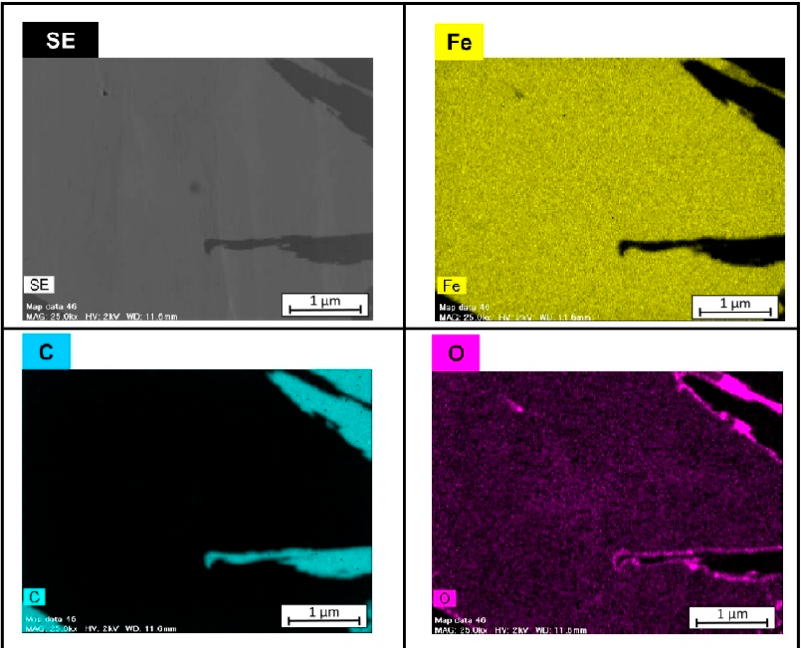
Cu Figure 4. Cross-sectional SEM image of Fe–graphite composite plating layer. Figure 4. Cross-sectional SEM image of Fe–graphite composite plating layer. Figure 4. Cross-sectional SEM image of Fe–graphite composite plating layer. Figure 4. Cross-sectional SEM image of Fe–graphite composite plating layer.